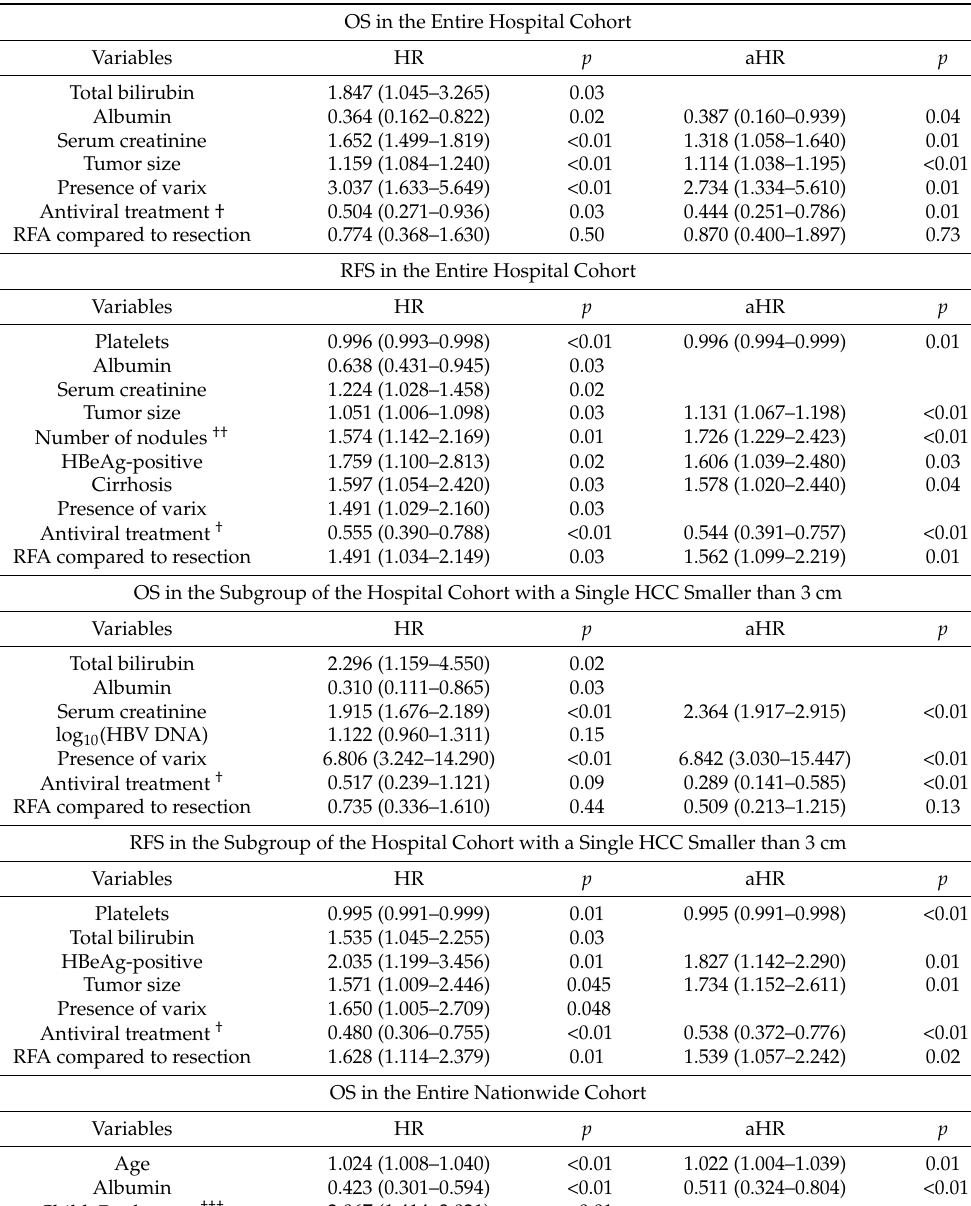
Table 2. Univariable and multivariable Cox analyses for OS and RFS in the entire hospital cohort, OS and RFS in the subgroup of the hospital cohort with a single HCC smaller than 3 cm, and OS in the entire nationwide cohort after IPTW. Hazard ratio and 95% CI were calculated, and aHR was derived after multivariable Cox